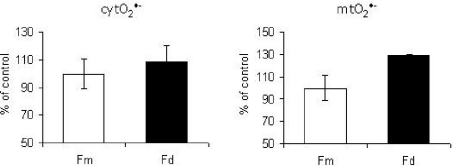
Superoxide production in human dermal fibroblasts. Cytosolic (cytO2 •−) and mitochondrial (mtO2 •−) superoxide production in neonatal human dermal fibroblasts (NHDF-Neonatal, Cat. n. CC-2509, Lonza) (Fm) and adult human dermal fibroblasts (NHDF-Adult, Cat. n. CC-2511, Lonza) (Fd). Superoxide production was measured as previously described in [12].